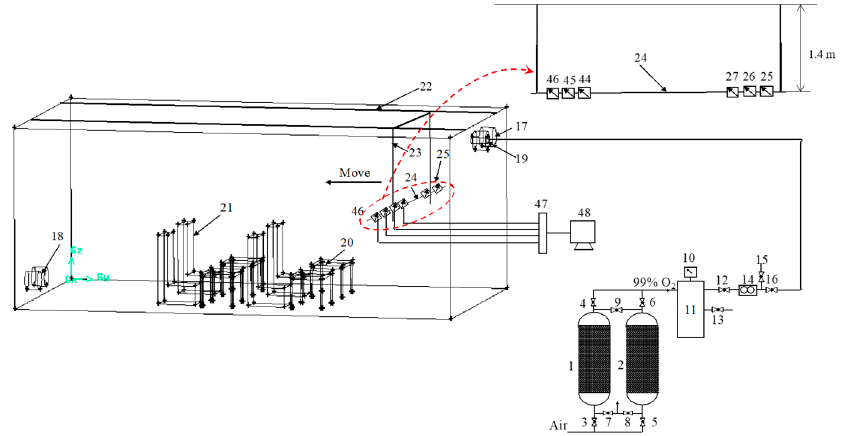
Figure 1. Schematic diagram of the experimental setup. (1) PSA adsorber; (2) PSA adsorber; (10) Zirconia sensor oxygen measurement system; (11) Buffer tank; (3), (4), (5),(6), (7), (8), (9), (12), (13), (15), (16) Ball valve; (14) Rotometer; (17) Air supply vent; (18) Air return vent; (19) Oxygen delivery port; (20) Table; (21) Chair; (22) Suspended track; (23) Wire; (24) Holder of the oxygen sensor; (25)~(46) Oxygen sensors; (47) Data collector; (48) Computer.